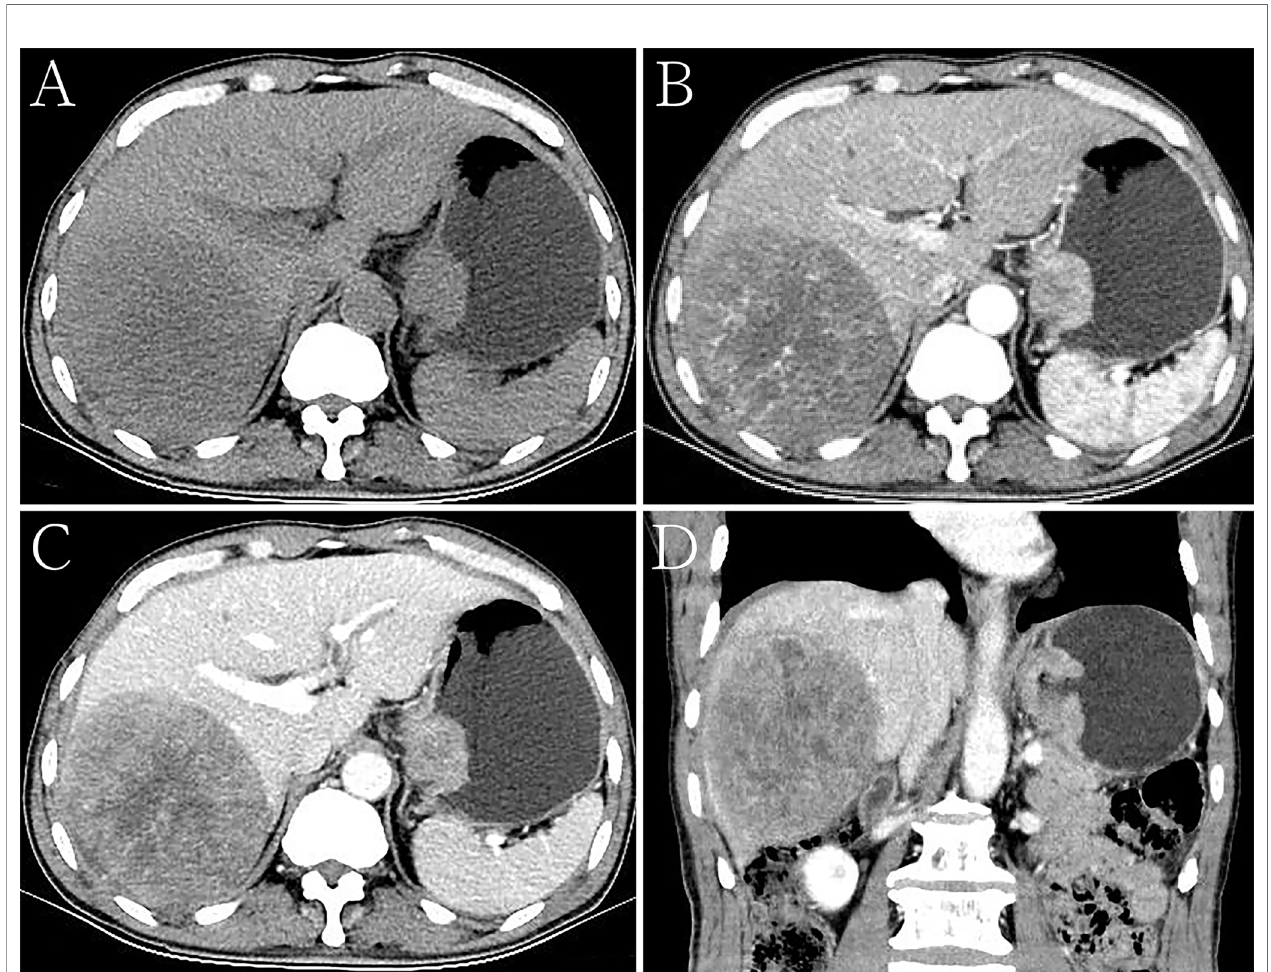
FIGURE 3 | Hepatoid adenocarcinoma of the stomach with liver metastases in a 68-year-old man. (A) Unenhanced computed tomography (CT) image of the stomach showing an intraluminal mass of homogeneous attenuation, with a smooth surface, in the cardia and fundus. The CT attenuation was approximately 46 Houns fi eld units (HU). A round low-density area was found in the liver. (B – D) Contrast-enhanced CT images showing obvious inhomogeneous enhancement of the mass, with the peak value of the tumor observed in the arterial phase. The thickest diameter of the mass was 3.4 cm. Ulceration was seen on the surface of the lesion on the multiplanar reconstruction (MPR) image. The Borrmann classi fi cation was type III. The CT attenuation in the arterial and venous phases were approximately 69 and 89 HU, respectively. The degree of enhancement of intrahepatic metastases was similar to that of the primary gastric lesions. (B) Arterial phase of the contrast-enhanced image. (C) Portal phase of the contrast-enhanced image. (D) Portal phase of the contrast-enhanced coronal